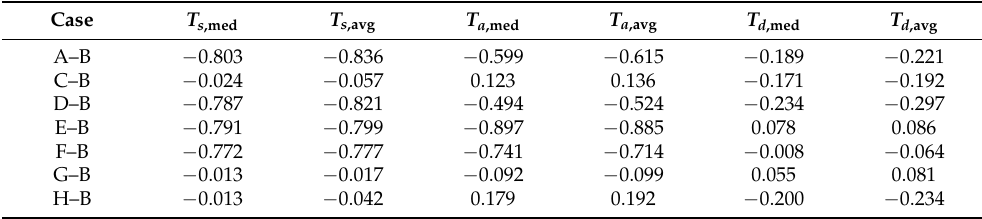
Table 11. Difference of T s , T a and T d from case